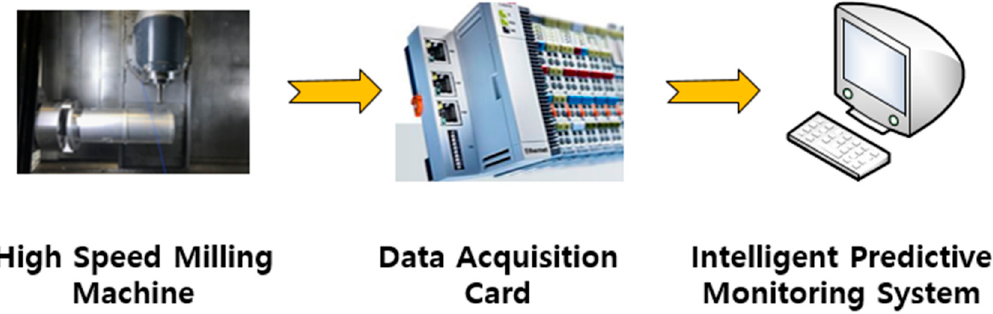
Figure 3. Tool conditions monitoring in high speed milling process.